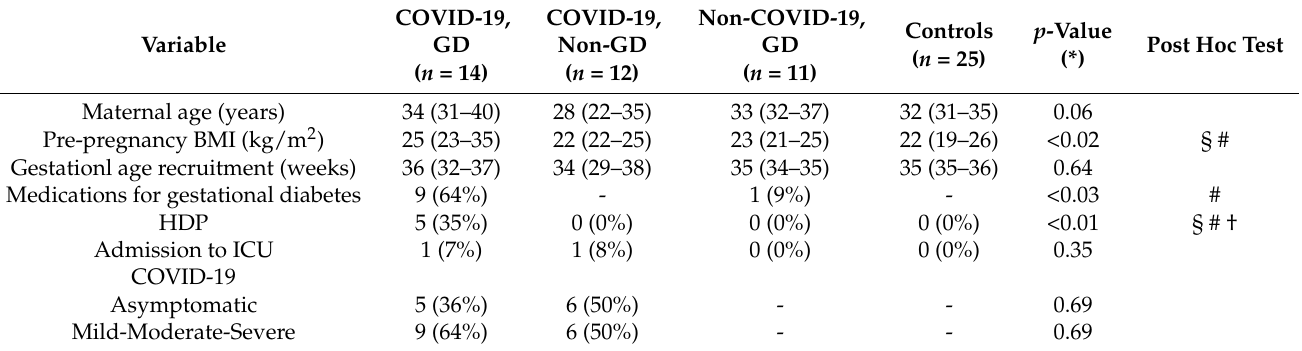
Table 1. Maternal demographic and clinical